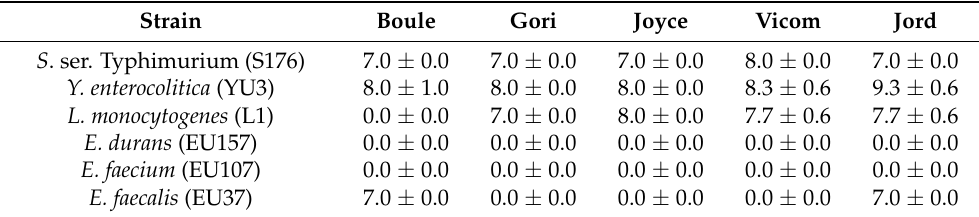
Table 3. Antimicrobial activity: Results of the agar diffusion test of the tested EOs at 10% on bacterial strains. Growth inhibition zone expressed in millimeters.